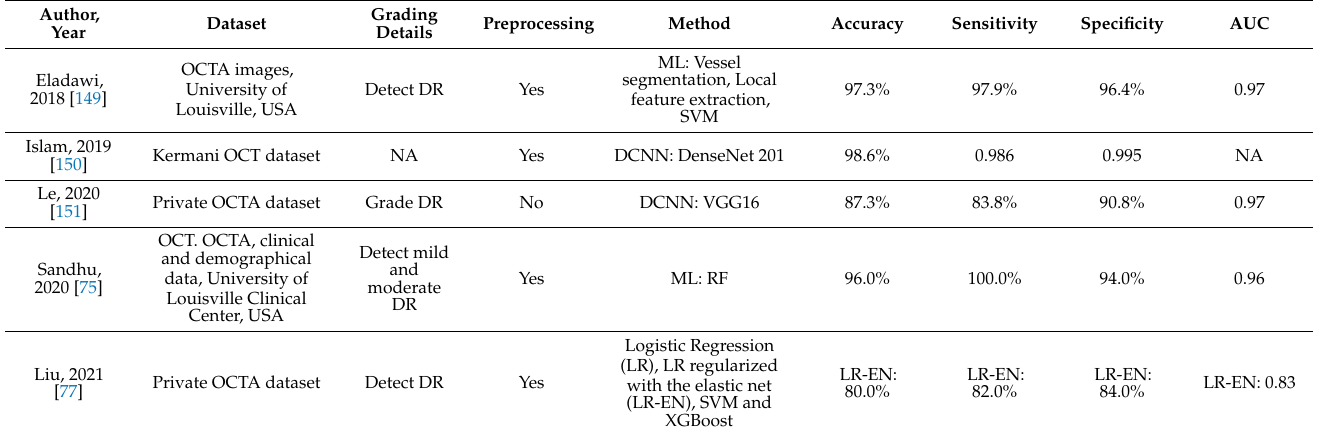
Table 4. Classification-based studies in DR detection using OCT and